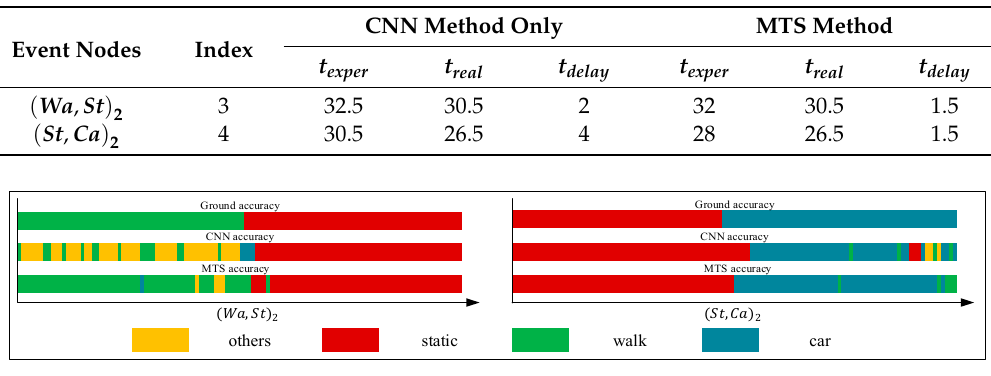
Figure 17. Graphs of (cid:104) Ca : Wa (cid:105) Figure 17. Graphs of < (cid:1829)(cid:1853): (cid:1849)(cid:1853) > (cid:2869) . Figure 17. Graphs of < (cid:1829)(cid:1853): (cid:1849)(cid:1853) > (cid:2869) . Figure 17. Graphs of < (cid:1829)(cid:1853): (cid:1849)(cid:1853) > (cid:2869) . Table 9. Basic SE of < (cid:1849)(cid:1853): (cid:1829)(cid:1853) > (cid:2870) . Table 9. Basic SE of (cid:104) Wa : Ca (cid:105) Table 9. Basic SE of < (cid:1849)(cid:1853): (cid:1829)(cid:1853) > (cid:2870) . Table 9. Basic SE of < (cid:1849)(cid:1853): (cid:1829)(cid:1853) > (cid:2870) .